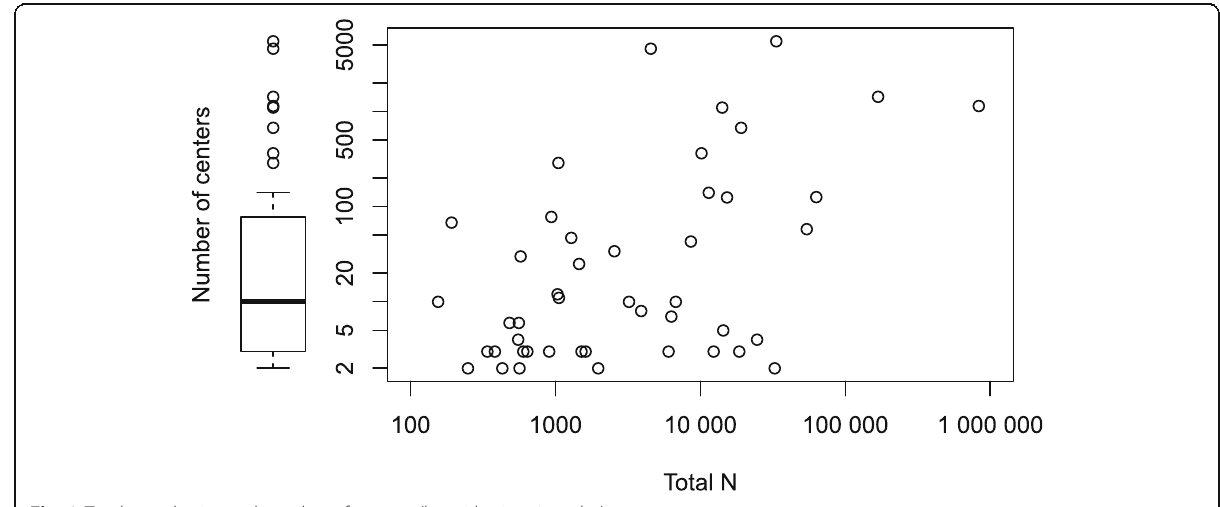
Fig. 3 Total sample size and number of centers (logarithmic axis